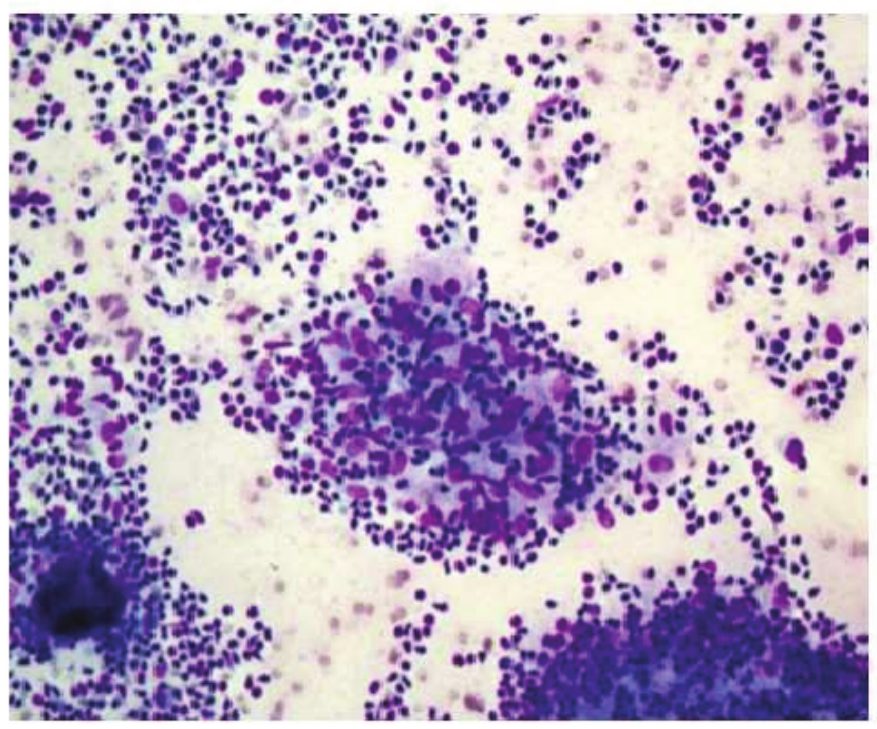
Figure 2 : Tuberculosis lymphadenitis with necrotizing shows granulomas variable in size with a mixture of epithelioid macrophages and